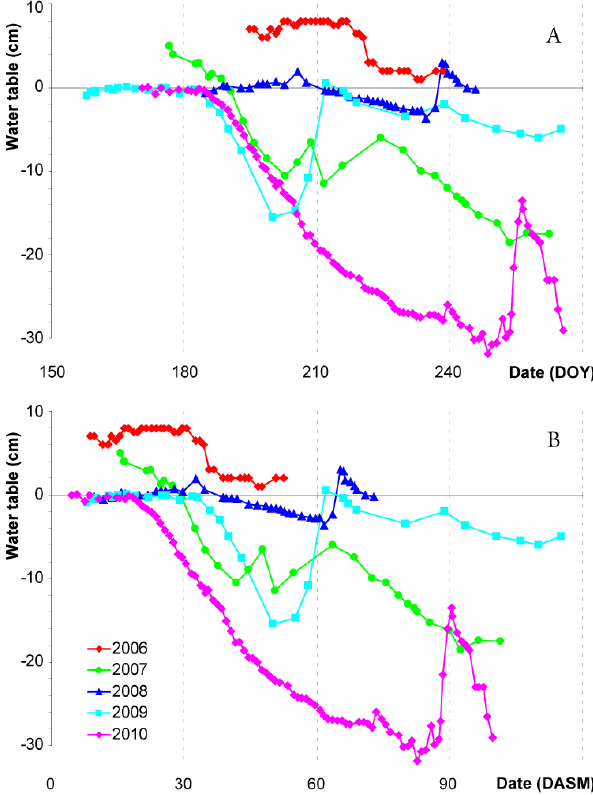
Figure 1. Fig. 1. Soil temperature dynamics at 3 depths. A , D 5cm; B , E 10cm; C , F 15cm depth. A , B , C normalized to day of year (DOY); D , E , F normalized to day after snowmelt (DASM).